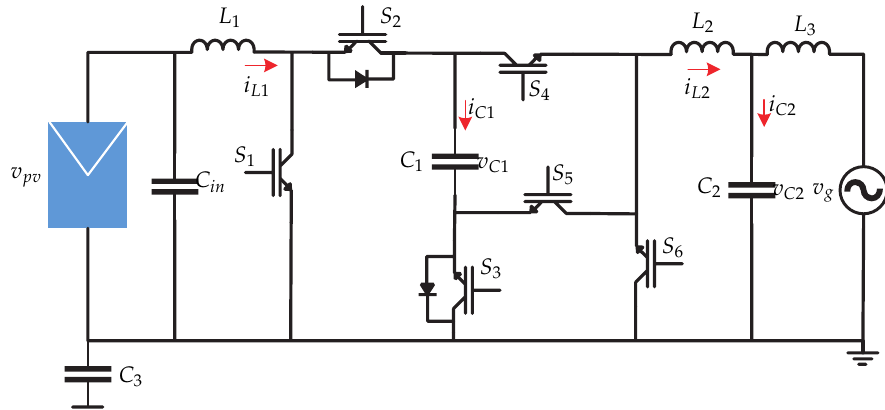
Figure 8. Microinverter’s topology proposed in [18].